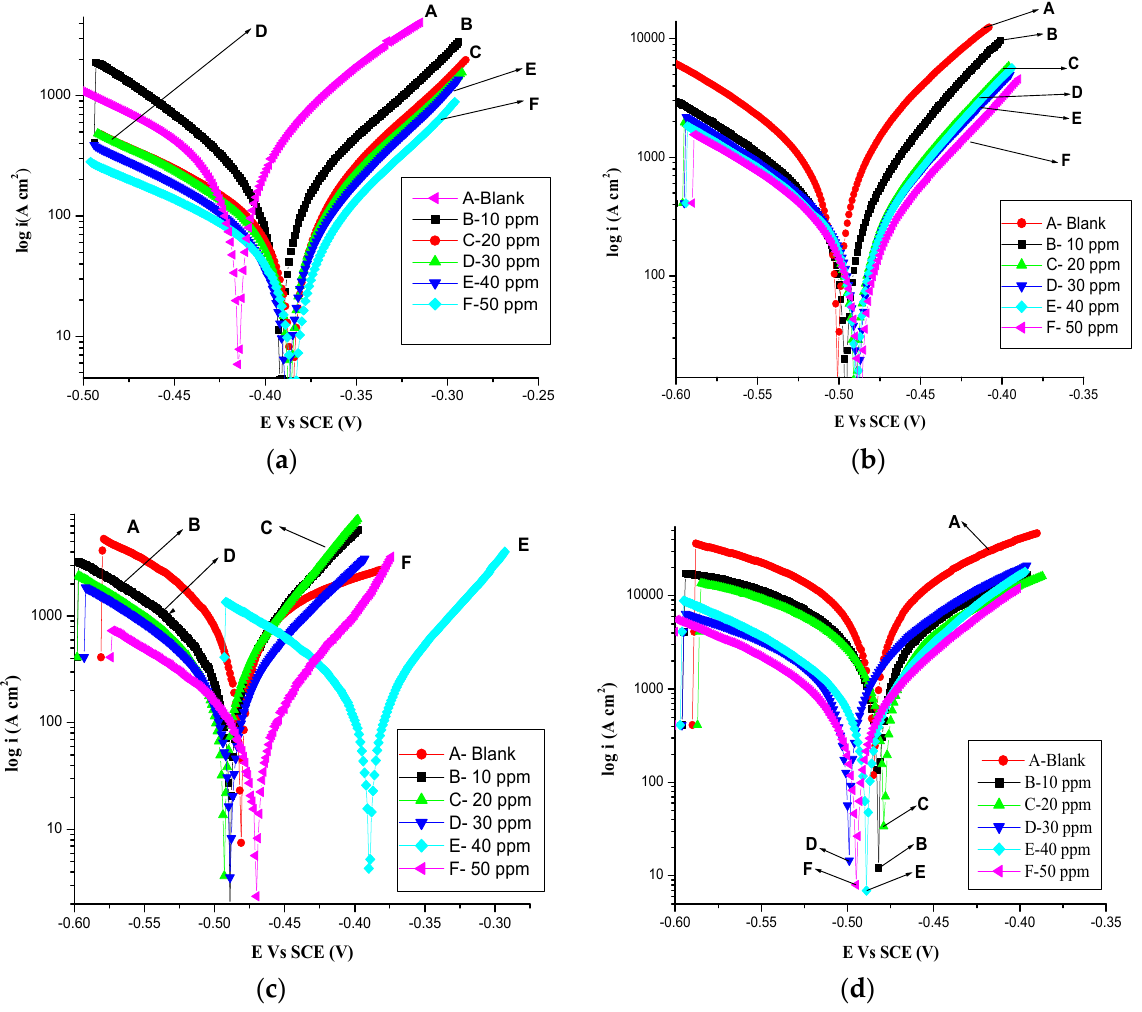
Figure 8. Soft cast steel Tafel polarization graphs without and with the various concentrations of olmesartan in 1 mol dm − 3 HCl at elevated temperatures of ( A ) 303 K, ( B ) 313 K, ( C ) 323 K, and ( D ) 333 K. Table 3. The corrosion parameters by potentiodynamic polarization measurement.